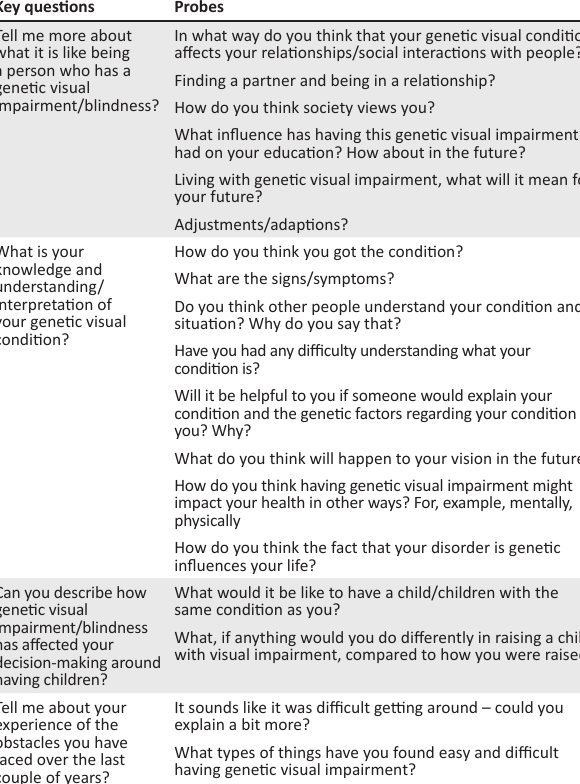
TABLE 1: Question guide. Key questions Probes